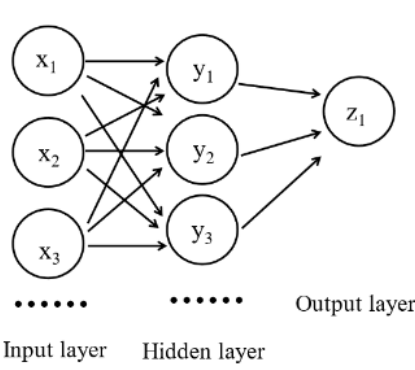
Figure 2. Structure of BP-ANN with three layers.